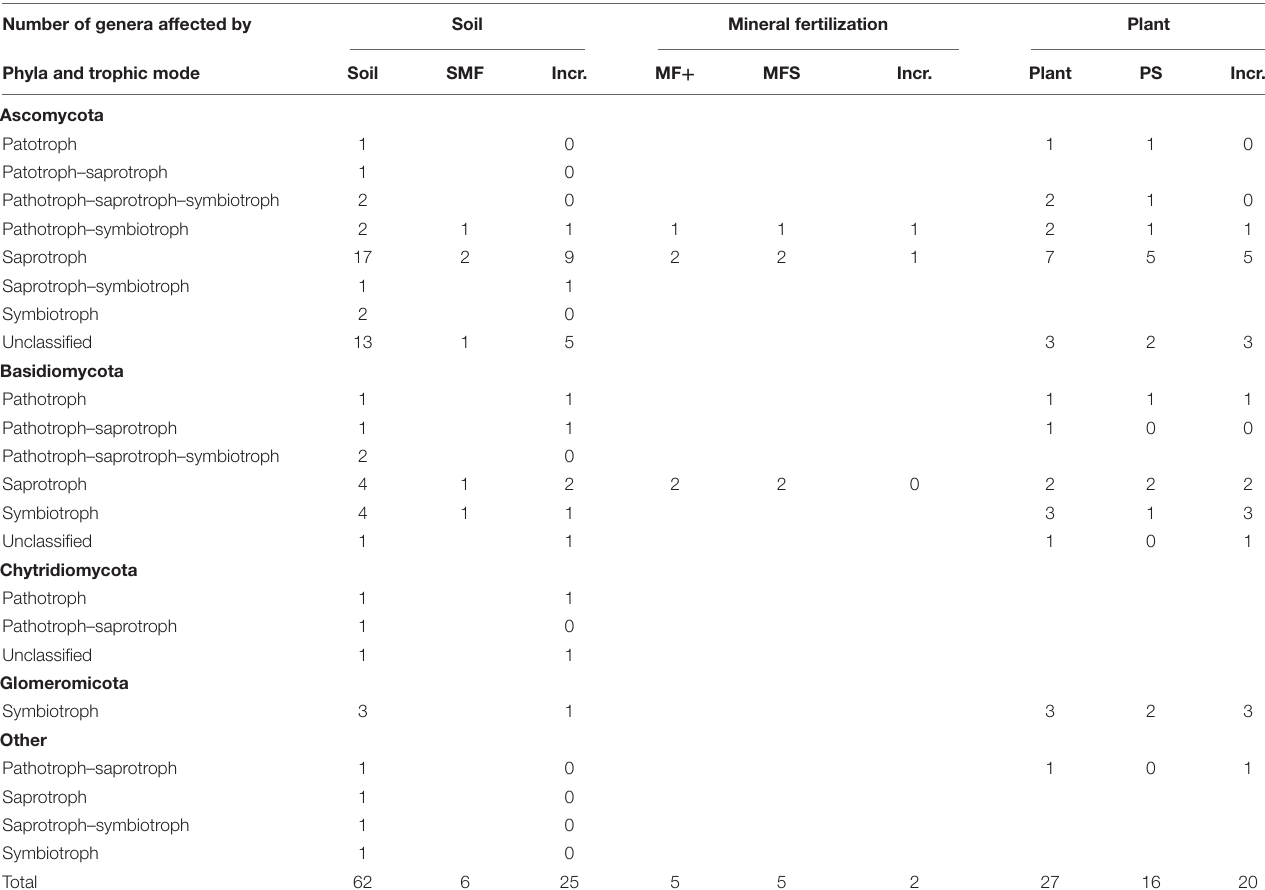
TABLE 7 | Number of genera form the 100 most abundant genera of fungi affected by soil type (compost addition), mineral fertilization, and presence of plant (olive saplings). Number of genera affected by Soil Mineral